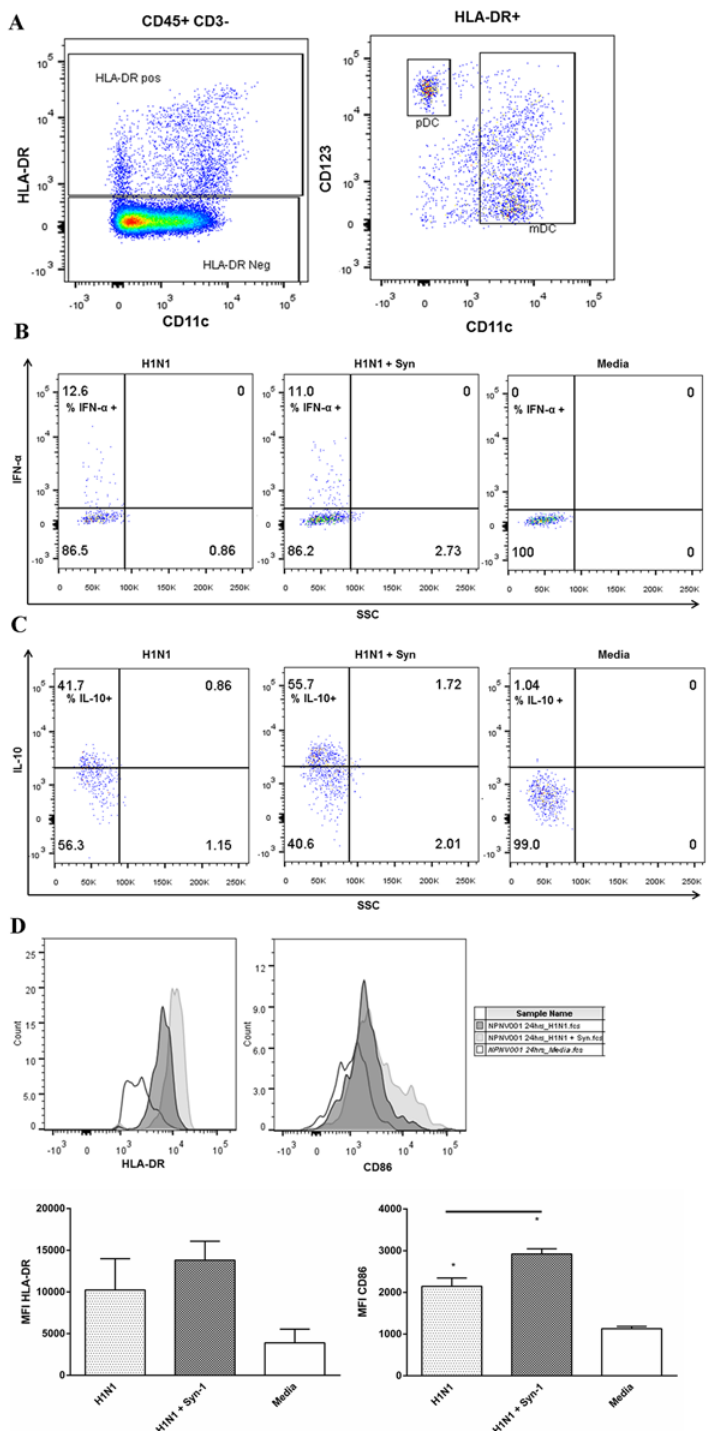
Fig 3. Flow cytometric analysis of PBMCs showing that pDCs are responsible for the release of IFN- α and IL-10. PBMCs were infected with H1N1pdm09 MOI 0.1 for 48hrs with and without syncytin-1. The cells were then subjected to surface and intracellular cytokine staining and flow cytometry to determine cell populations and cytokine release. The pDC population was determined using CD3-/CD45+ cells which were also HLA-DR+ and CD123+ (A). This population was analysed for cytokine release using